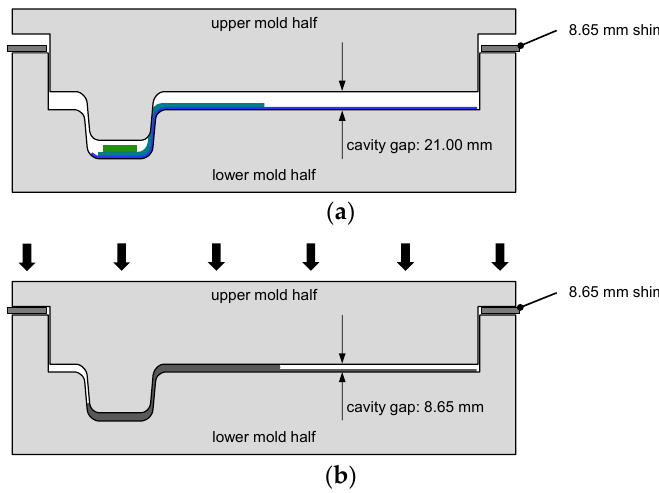
Figure 6. Schematic illustration of the shimming technique for short shot experiments in a cross-sectional view; ( a ) initial pre-heating position of the upper mold half; ( b ) final position of the upper mold half touching the 8.65 mm shims and showing the short shot of the pressed HexMC charge.